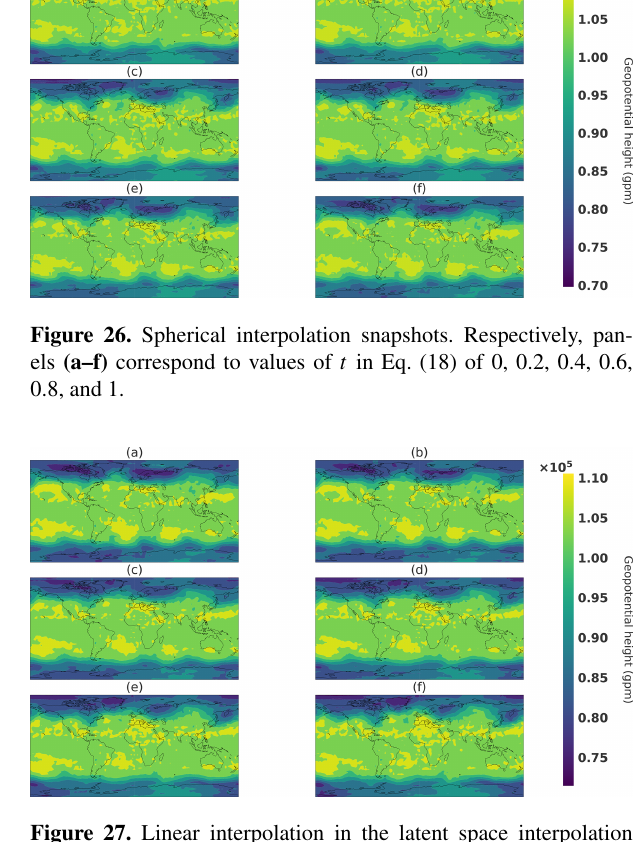
Figure 27. Linear interpolation in the latent space interpolation snapshots. Respectively, panels (a–f) correspond to values of t in Eq. (17) of 0, 0.2, 0.4, 0.6, 0.8, and 1.